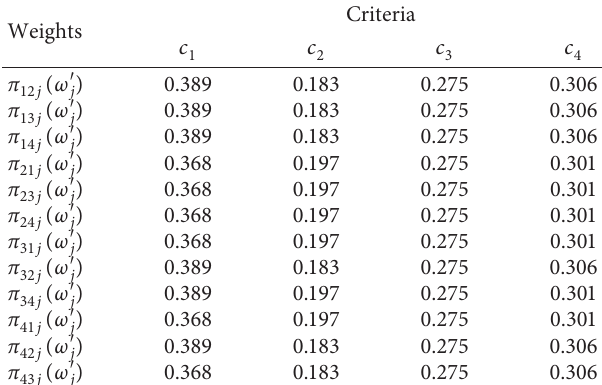
Table 1: Extensions of TODIM with various FSs. Table 2: Transformed probability weights.